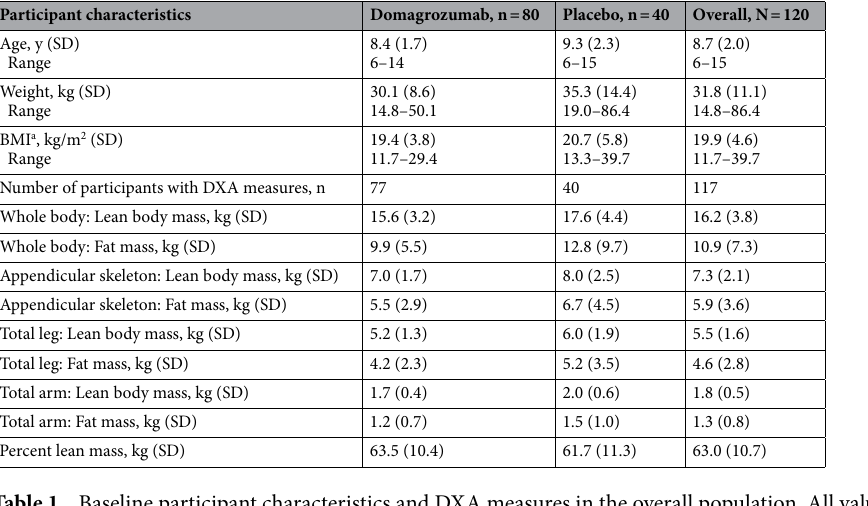
Table 1. Baseline participant characteristics and DXA measures in the overall population. All values represent the mean unless otherwise stated. a BMI was defined as weight/(height × 0.01) 2 . BMI Body mass index; DXA Dual-energy X-ray absorptiometry; SD Standard